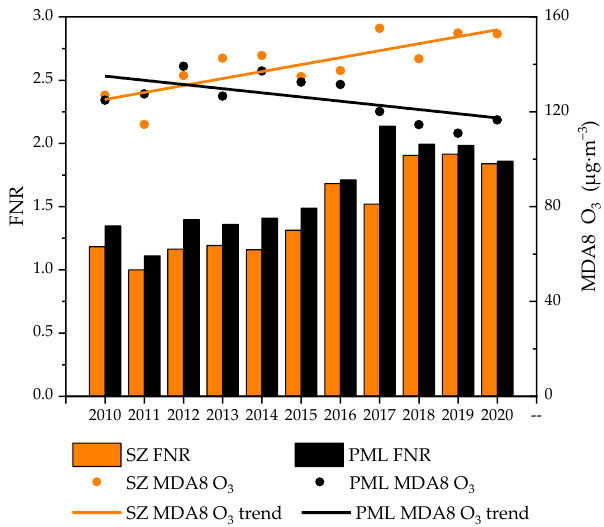
Figure 7. Changes in FNR (HCHO to NO 2 ratio) and ozone MDA8 in urban (SZ) and suburban (PML) areas in April – September from 2010 to 2020.